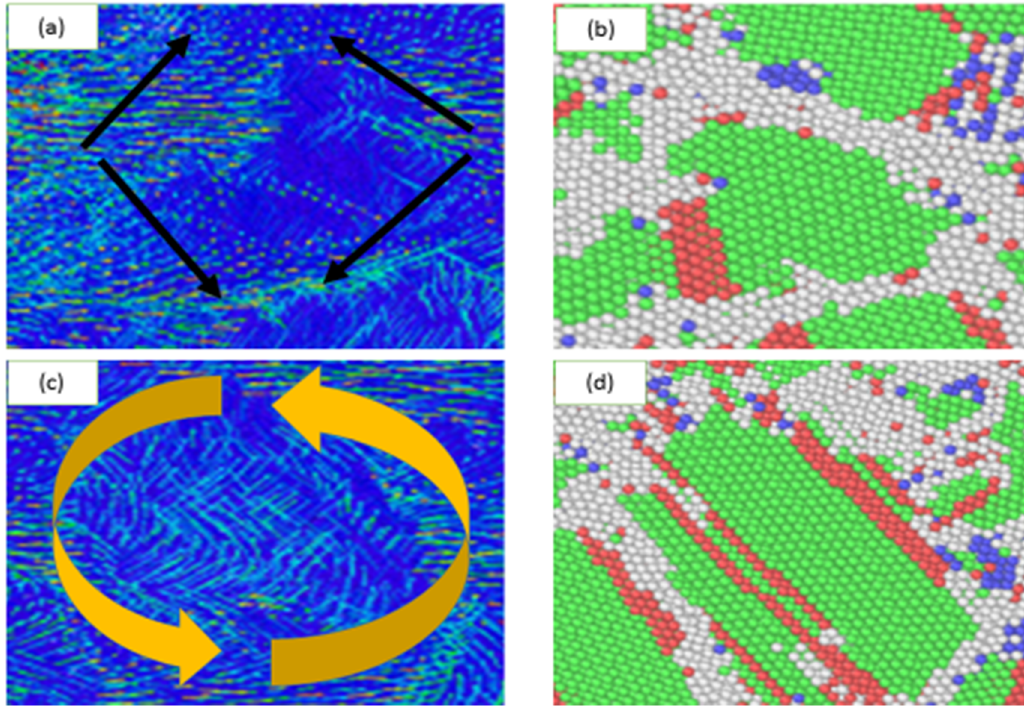
Figure 7. Snapshots showing ( a , b ) grain boundary sliding and ( c , d ) grain rotation for the sample with an average grain size of 3.6 nm. ( a , c ) were generated using atomic displacement vectors to visualize the grain boundary sliding and grain rotation, respectively. ( b , d ) were generated using the CNA method to visualize the grain boundary regions.